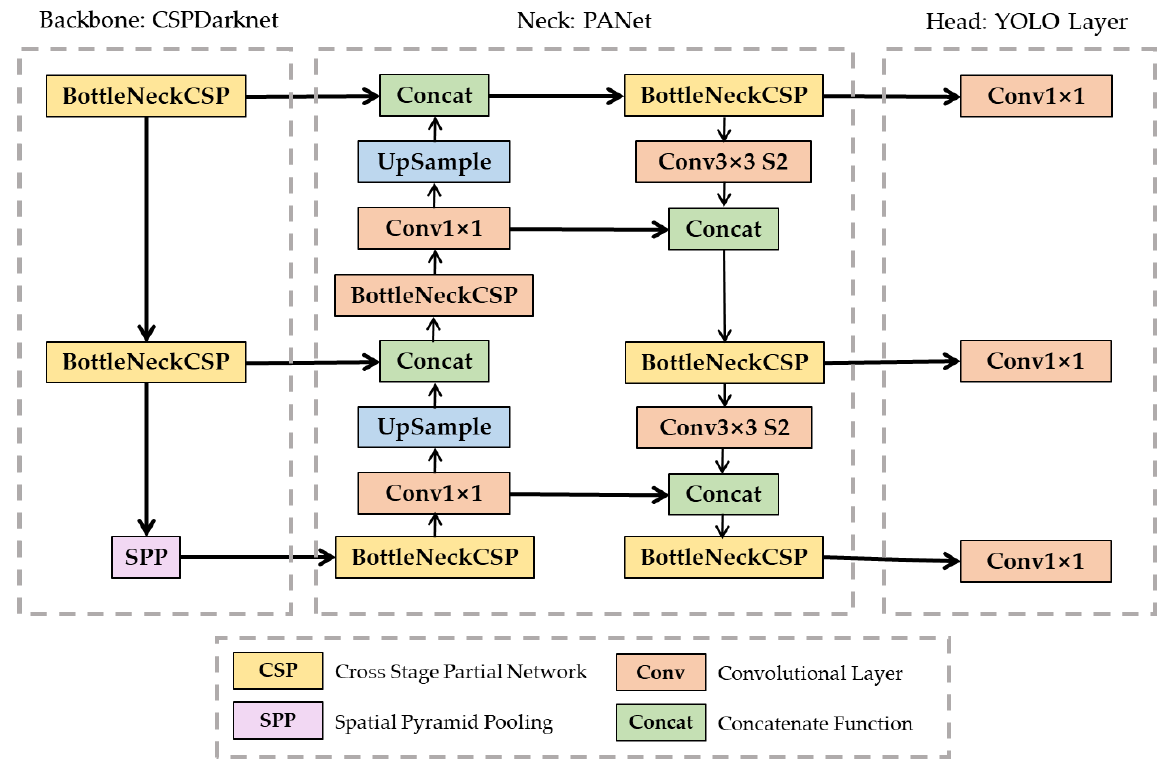
Figure 1. Neural network architecture of YOLO-v5.